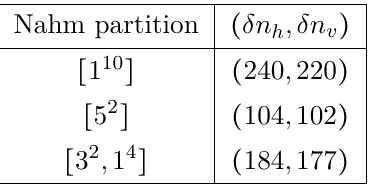
Table 7. Table containing the data defining the punctures for the 4d E 7 × E 7